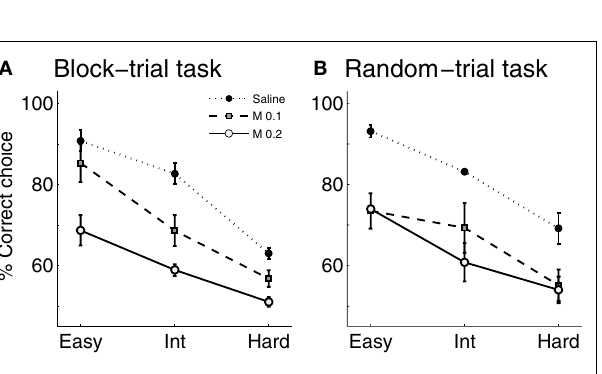
signifi cant main effects of drug ( F